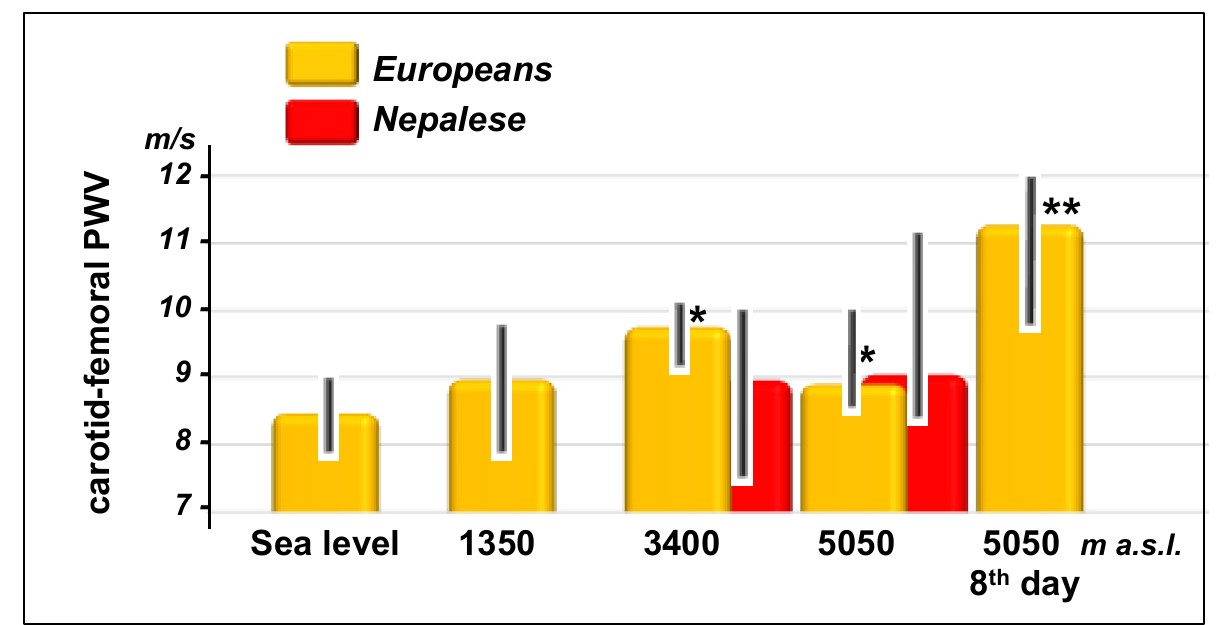
Figure 3. Changes in carotid-femoral pulse wave velocity (PWV) during the ascent and stay at very high altitudes in Europeans and Nepalese. Data are shown as median and interquartile range. Significance versus basal condition (sea level for lowlanders and 3400 m a.s.l. for highlanders) is expressed by the p -value: *, p < 0.05; **, p < 0.001.